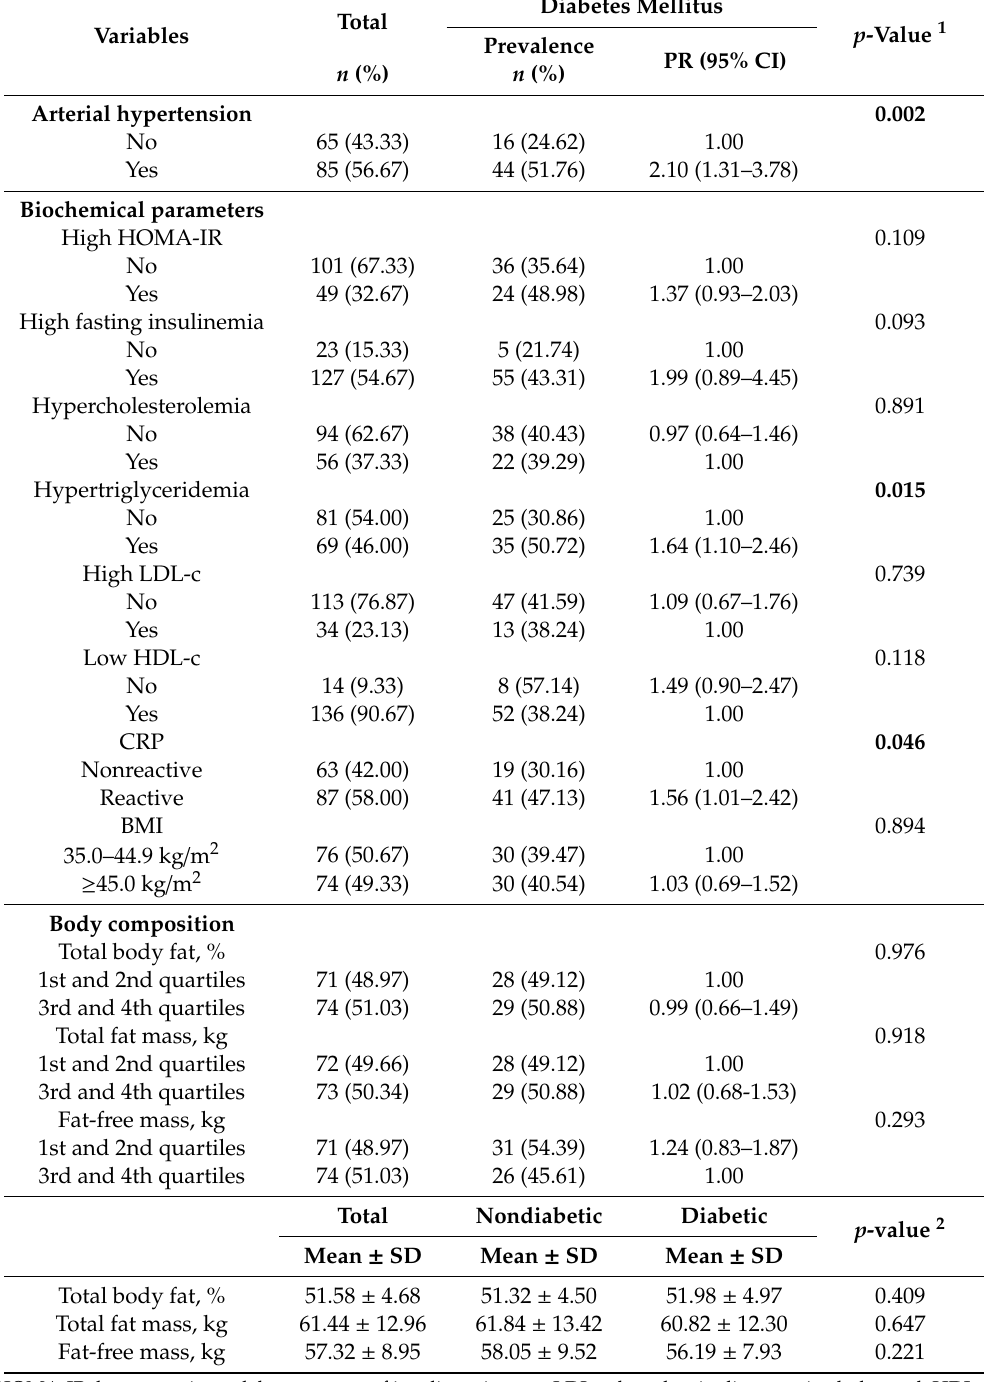
Table 2. Prevalence of type 2 diabetes mellitus and its associated factors in class II and III obesity with respect to systemic arterial hypertension, biochemical parameters, obesity class, and body